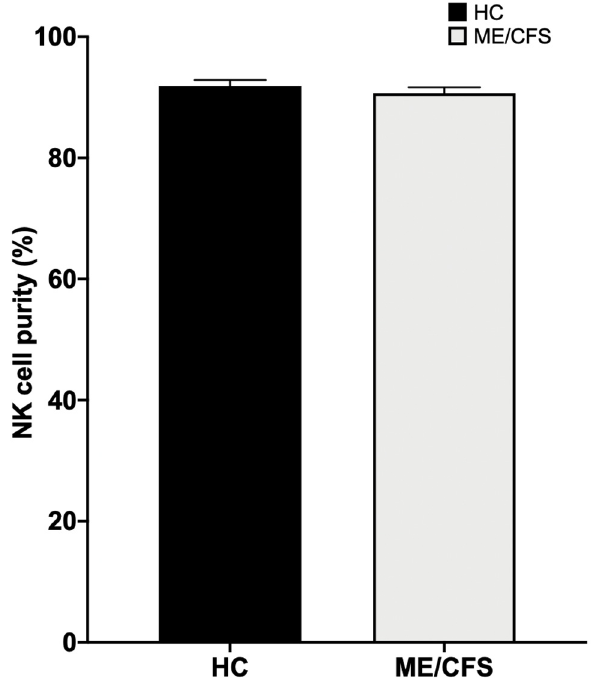
Figure A1. NK cell purity; n = 17 for HC and n = 17 for ME/CFS. NK cells were stained with CD3-APC-H7 (0.5 µg/5 µL) and CD56-Pe-Cy7 (0.25 µg/5 µL) and acquired by flow cytometry. NK cells were defined as the CD3 - CD56 + lymphocyte population. Data are represented as the mean ± SEM as determined by independent Mann-Whitney U tests.